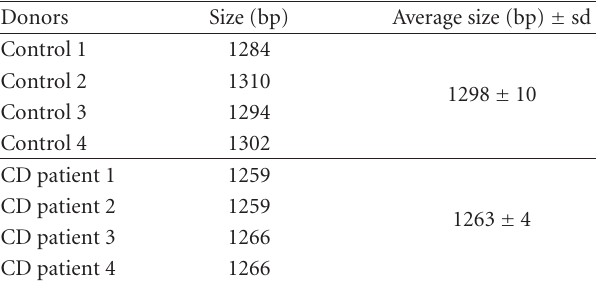
Table 2: Results of the DNA sequencing analysis of PBMCs for SSTR5 in 4 control donors and 4 CD patients. mRNA extraction was realized from PBMC of 4 CD patients and 4 control donors. cDNA was obtained after RT-PCR and PCR. Total cDNA was checked for integrity and concentration using the DNA 7500 LabChip kit on the Agilent 2100 bioanalyzer and for purity by reading the absorbance at 260 and 280 nm with ratios A260/A280 always between 1.8